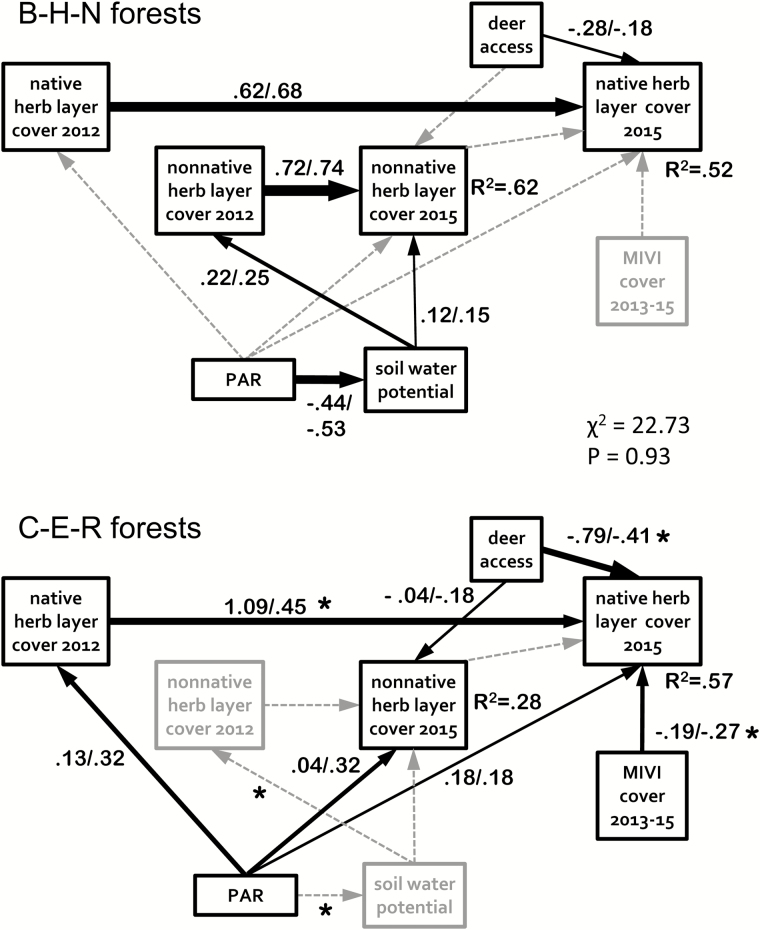
Multi-group SE model, with two groups of forests: Baldpate, Herrontown and Nayfield (B-H-N) and Curlis, Eames and Rosedale (C-E-R). Paths with an asterisk in the C-E-R group contributed significantly to the model-wide difference between the groups. Paths with solid black lines are labelled with unstandardized/standardized path coefficients and are significant in that group at P < 0.05. Non-significant paths are shown as dotted grey lines. Widths of the arrows indicate strength of the path based on the standardized path coefficient. R2 values indicate the proportion of the 2015 cover variables explained by the model. The χ2 fit statistic is for the entire multi-group model.